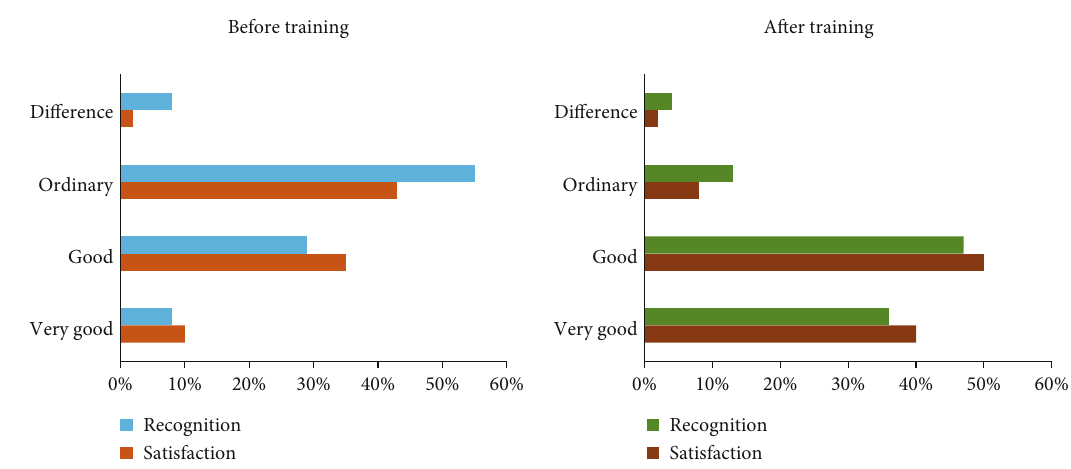
Figure 12: Teachers ’ feelings about new media-integrated music reading training in music reading training.